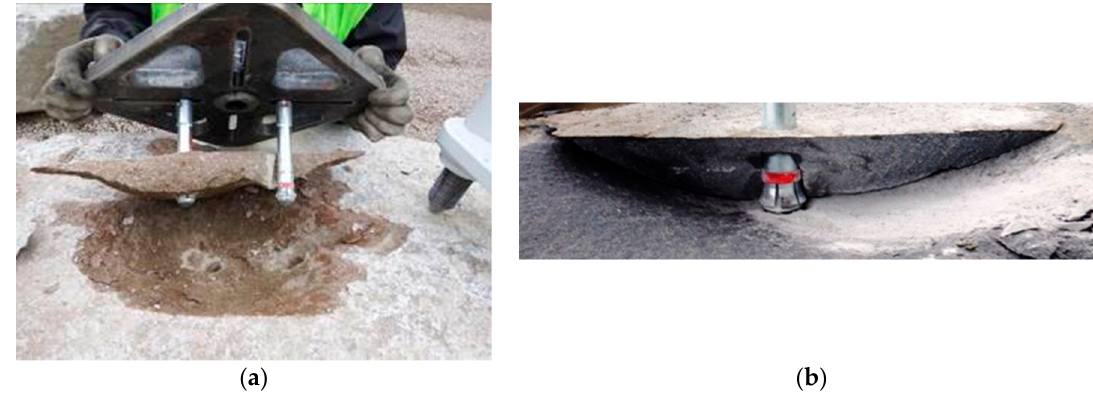
Figure 11. The cone failure specimens obtained in tests for the systems of ( a ) 2 anchors and ( b ) 1 anchor.